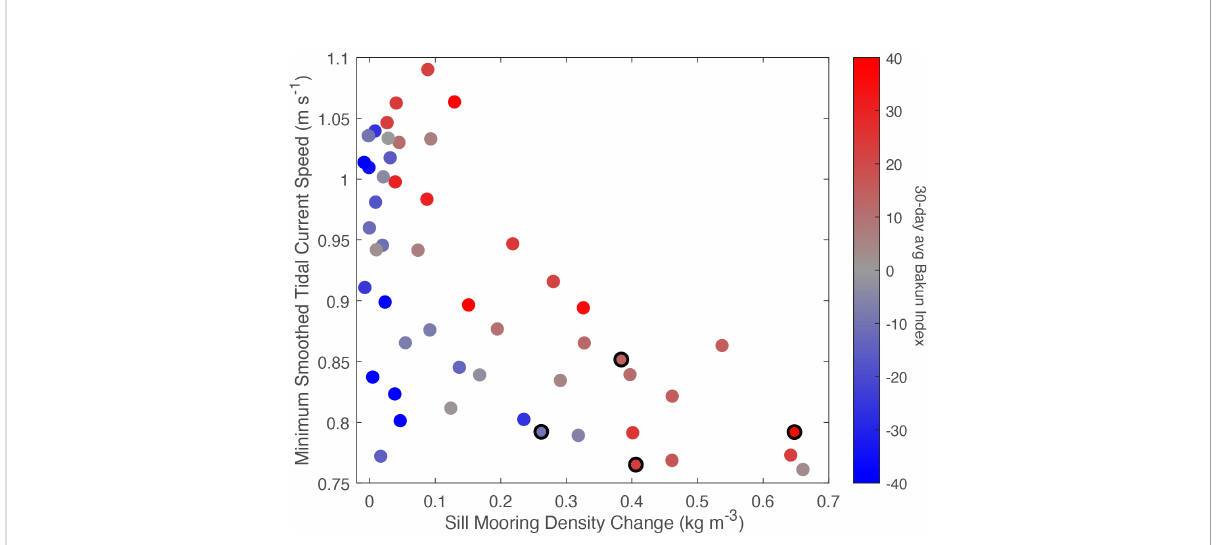
FIGURE 3 The minimum in the smoothed tidal current speed vs. the potential strength of a renewal event (change in potential density ( D s q ) observed at the Saanich Inlet sill mooring). Each renewal event is coloured by the average of the Bakun Index over the 30 days prior to the minimum smoothed tidal current speed. Events in 2016 (see next section) are outlined in